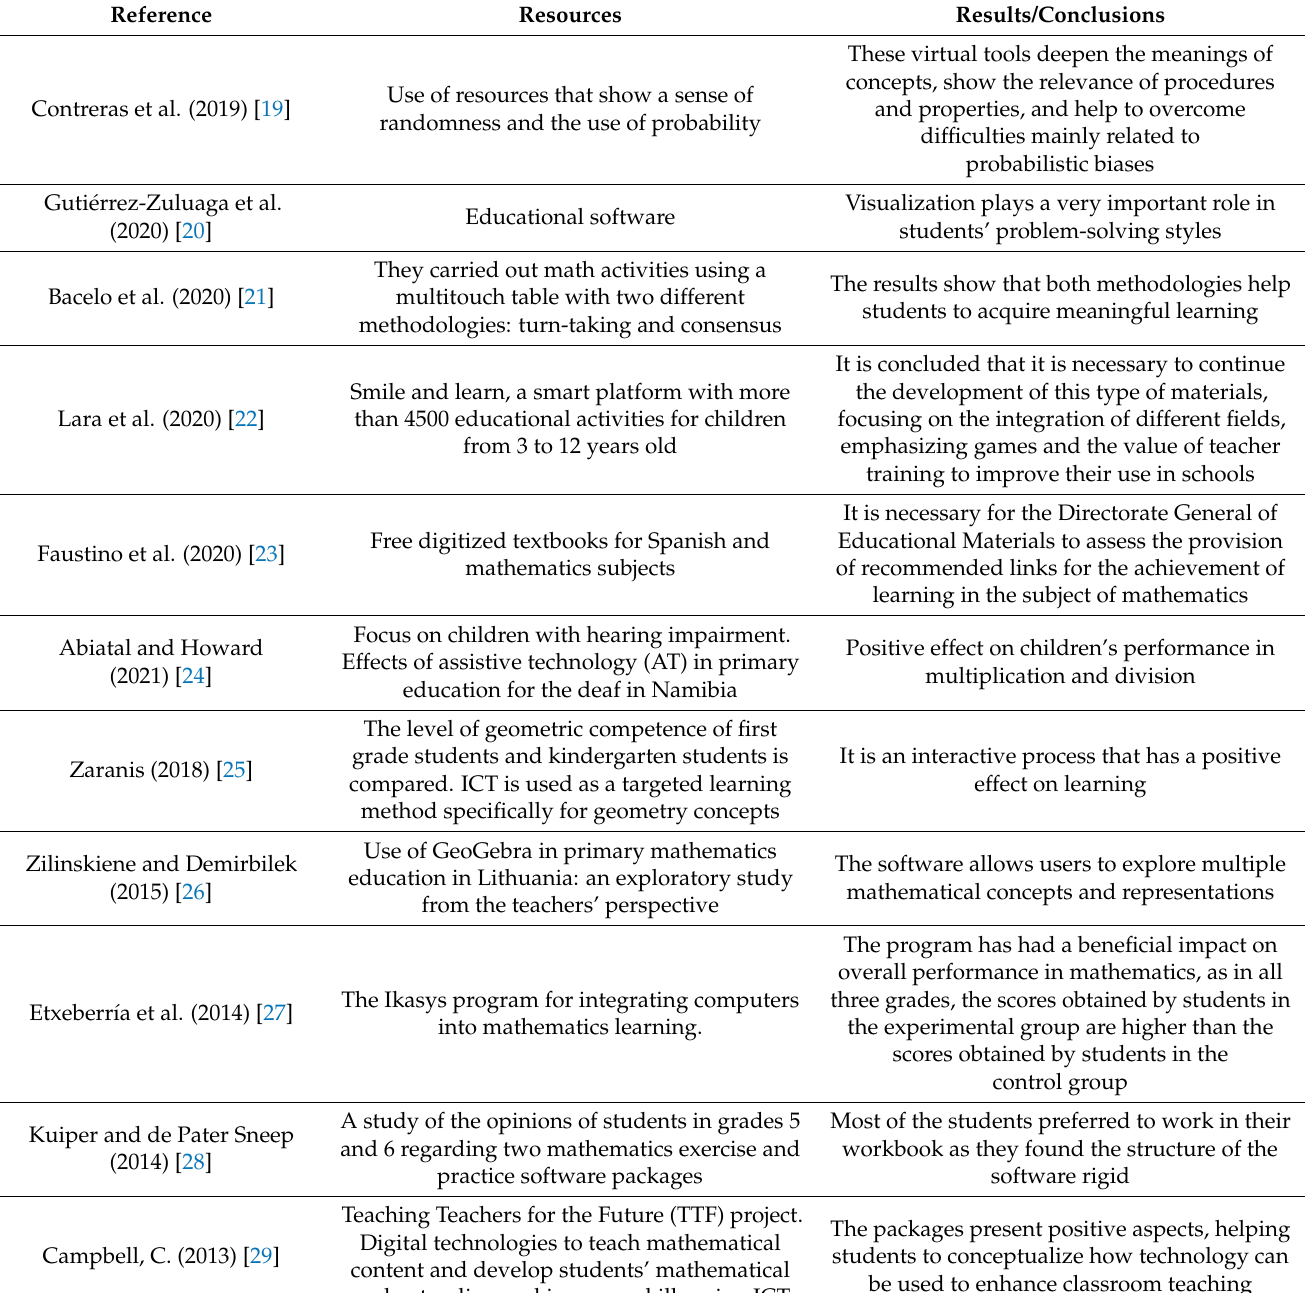
Table 4. Articles on the use of ICT for learning mathematics in primary school